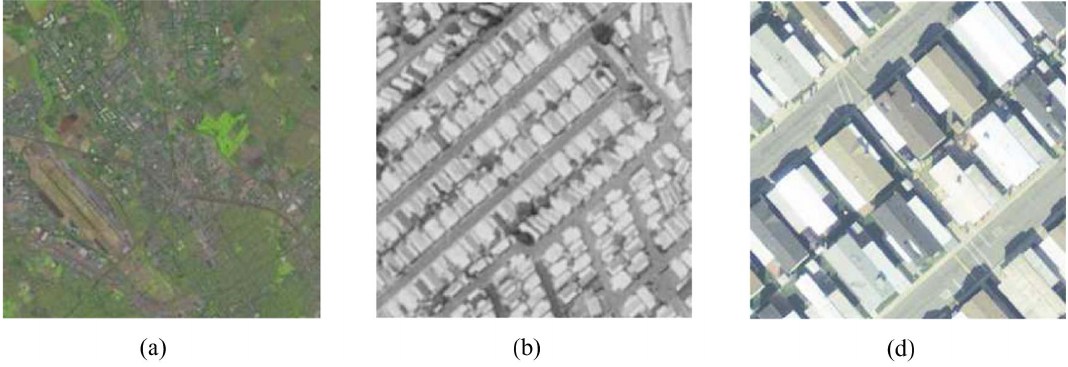
Figure 1. Images with a resolution of: ( a ) 30 m; ( b ) 1 m; ( c ) 0.3